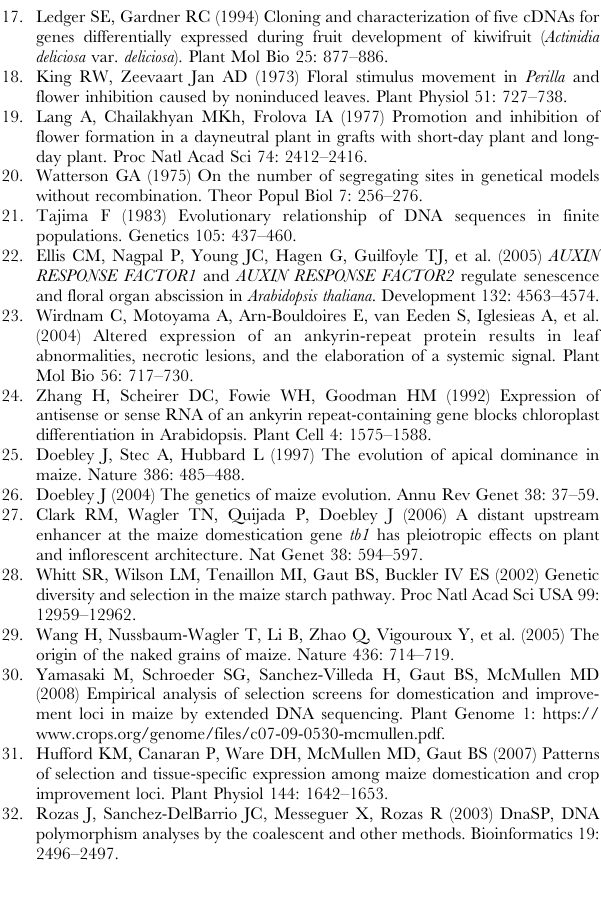
Table S2 List of candidate genes assayed and corresponding